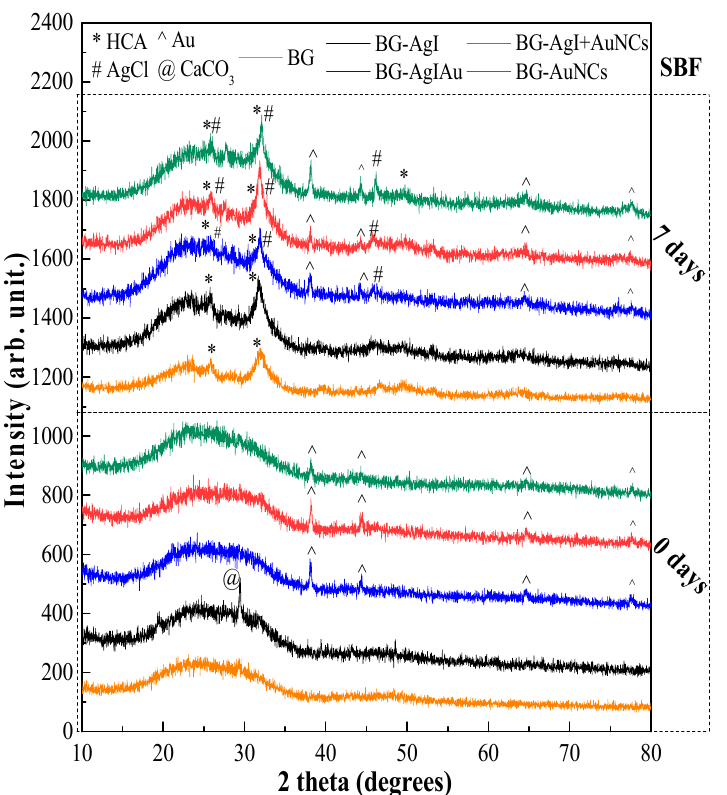
Figure 4. XRD patterns of the BG, BG-AgI, BG-AgIAu, BG-AgI+AuNCs, and BG-AuNCs samples before (0 days) and after (7 days) immersion in SBF.